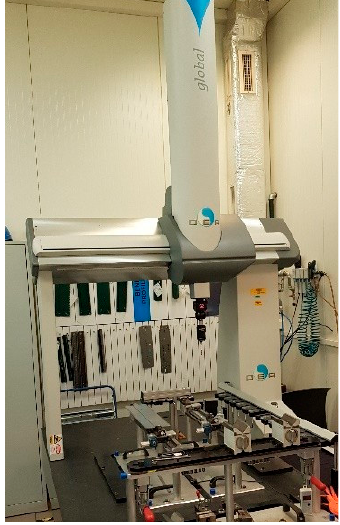
Figure 6. Measurement of the pattern with the DEA Global Coordinate Measuring Machine (the